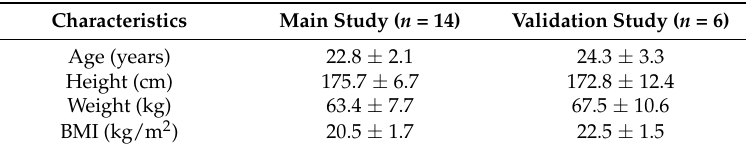
Table 3. Subject